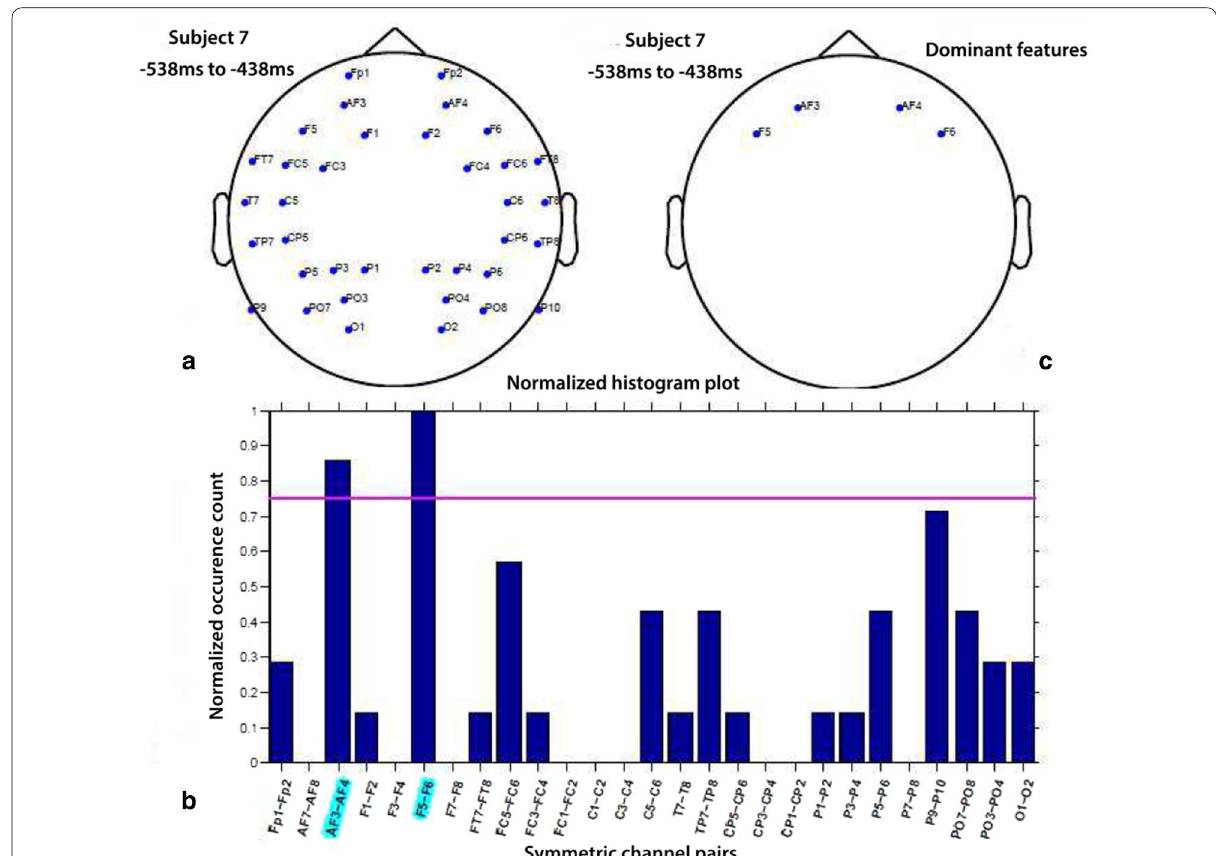
Fig. 6 Steps of common feature analysis: a channel pairs selected at least once over all folds, b normalized histogram plot of channel pairs and c only dominant channel pairs